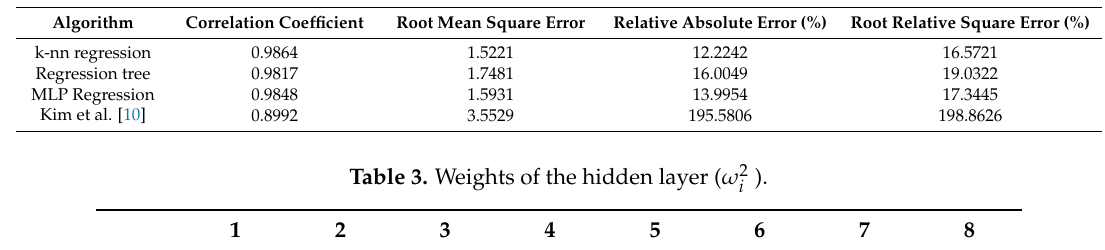
198.8626 Table 3. Weights of the hidden layer ( 𝜔 (cid:3036)(cid:2870) ). 1